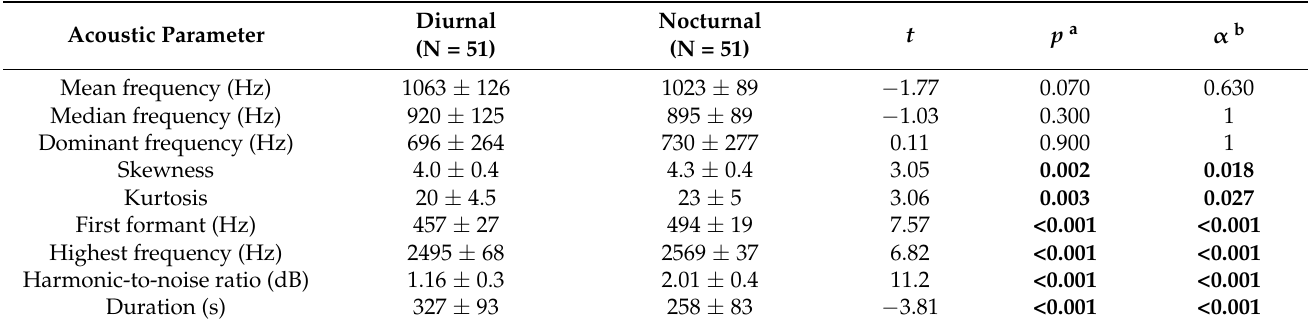
Table 4. Acoustic parameters (mean ± SD) for nocturnal and diurnal howling bouts of Guianan red howlers and results for linear mixed models ( t statistics and p values are indicated).